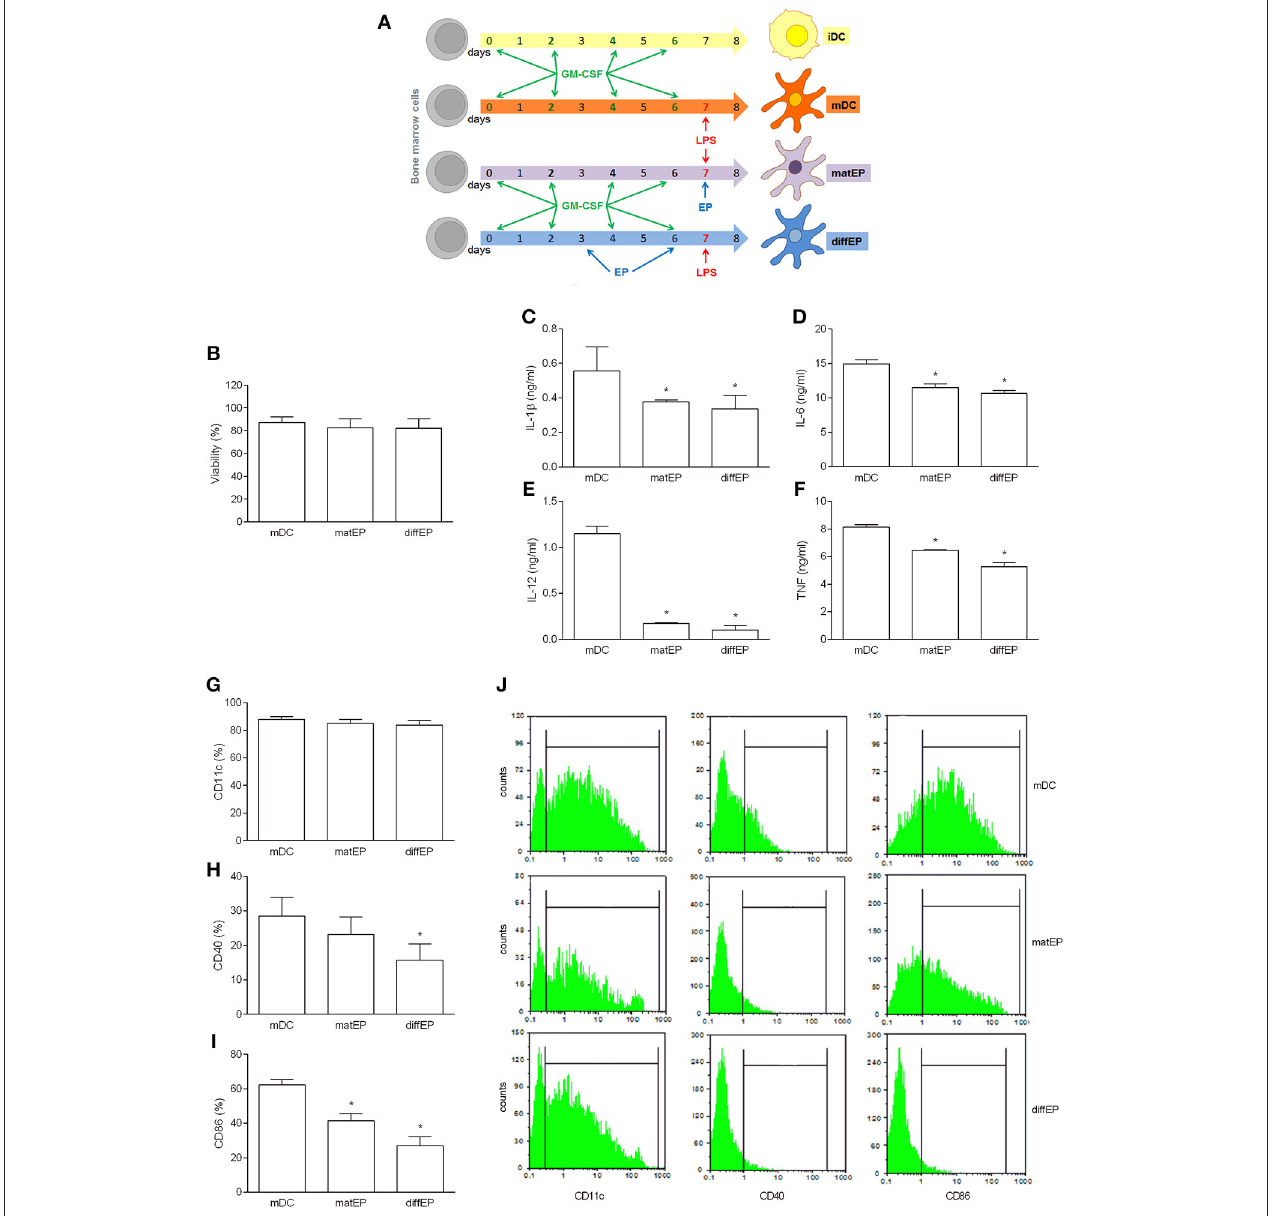
FIGURE 2 | Effects of EP on C57BL/6 mice DC. BMDC were obtained from C57BL/6 mice. They were treated with EP (3.1mM) for 24h simultaneously with LPS (“matEP”) or at days 3 and 6 of the propagation (“difEP”) or they were untreated with EP (mDC), as schematized (A) . Viability (B) was determined by trypan blue exclusion assay. Cytokines were determined in cell culture supernatants by ELISA (C–F) . Proportion of cells expressing the listed antigens was determined by cytofluorimetry (G–J) . Data are presented as mean + SD from at least three independent experiments. Data in (J) are representative plots. * p < 0.05, EP vs. mDC, one way ANOVA followed by Tukey’s multiple comparisons